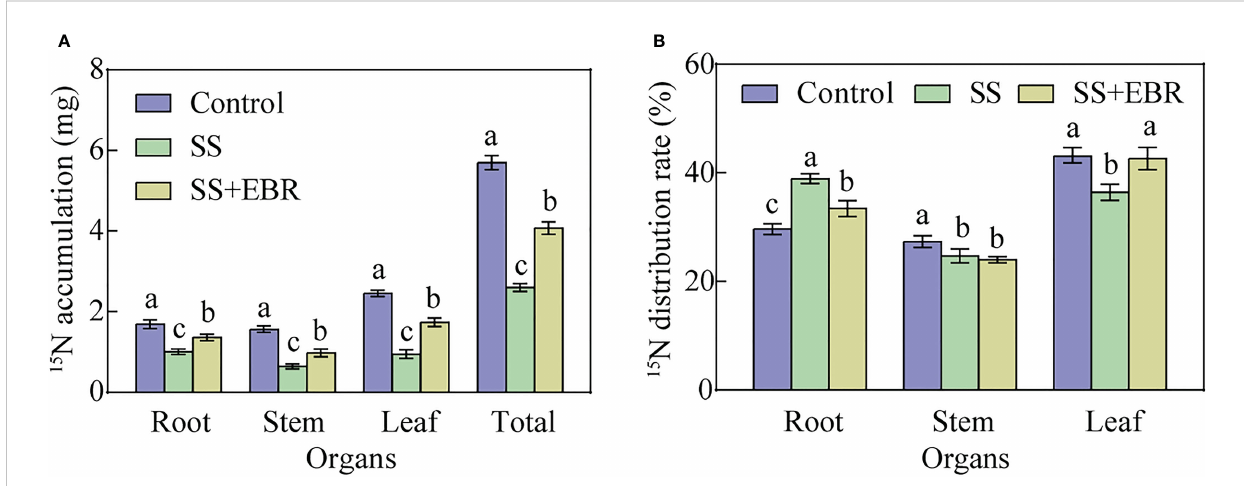
FIGURE 6 Effects of different treatment on apple rootstocks under NaCl stress in terms of 15 N accumulation (A) and 15 N distribution ratio (B) . The error bars represent the SD, and the different letters indicate signi fi cant differences ( P < 0.05).